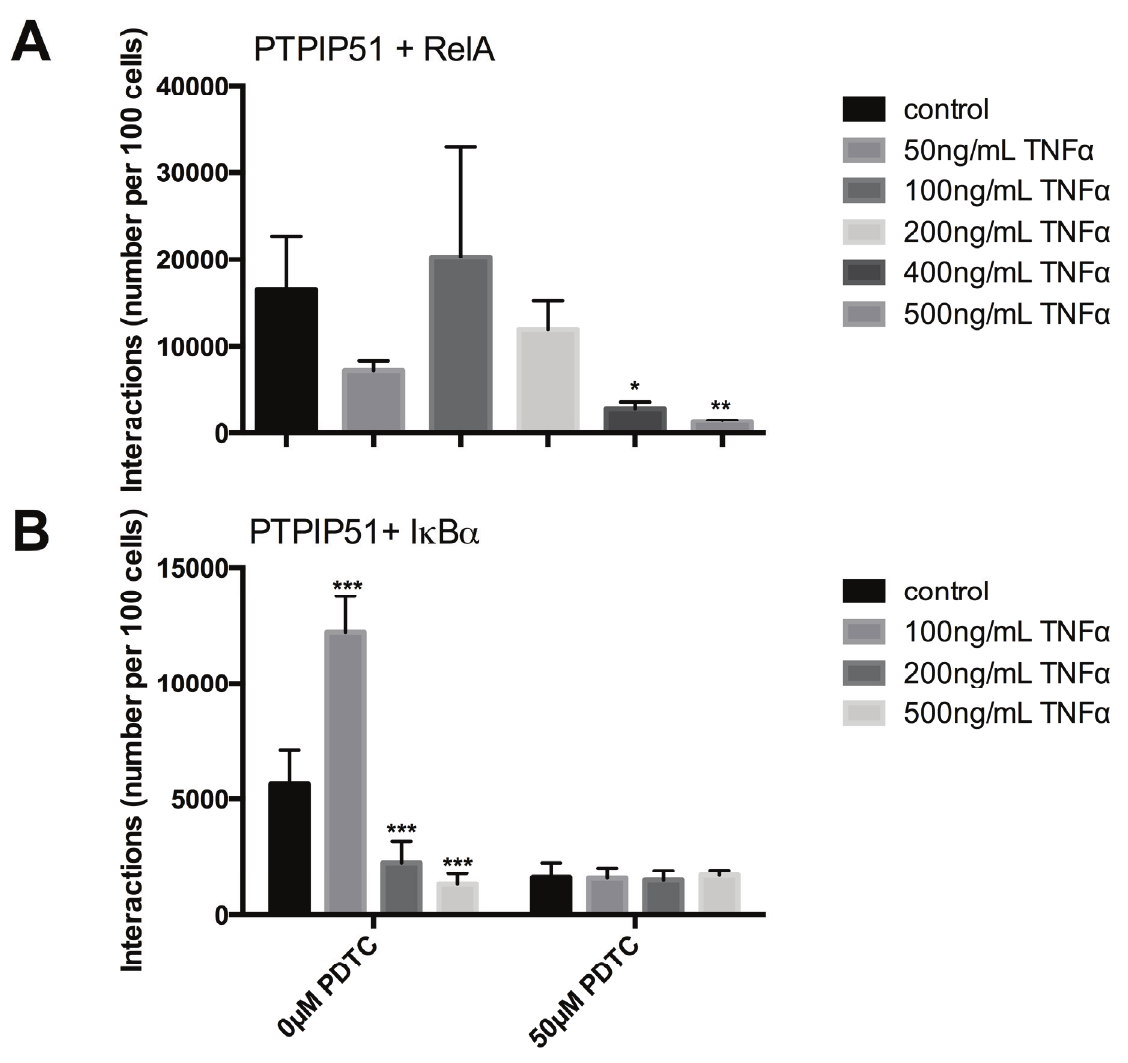
Figure 6. Quantitative analysis of PTPIP51 and RelA and PTPIP51 and IkB(cid:3) interactions evaluated by Duolink Image Tool software. ( A ) PTPIP51 and RelA interactions in human keratinocytes. Untreated controls, 50 ng/mL TNF(cid:3) treated cells, 100 ng/mL TNF(cid:3) treated cells, 200 ng/mL TNF(cid:3) treated cells, 400 ng/mL TNF(cid:3) treated cells, 500 ng/mL TNF(cid:3) treated cells. * ( p < 0.05), ** ( p < 0.01); ( B ) PTPIP51 and IkB(cid:3) interactions. Left panel: Untreated controls, 50 ng/mL TNF(cid:3) treated cells, 100 ng/mL TNF(cid:3) treated cells, 200 ng/mL TNF(cid:3) treated cells, 400 ng/mL TNF(cid:3) treated cells, 500 ng/mL TNF(cid:3) treated cells. *** ( p < 0.001). Right panel: controls, 50 ng/mL TNF(cid:3) treated cells, 100 ng/mL TNF(cid:3) treated cells, 200 ng/mL TNF(cid:3) treated cells, 400 ng/mL TNF(cid:3) treated cells, 500 ng/mL TNF(cid:3) treated cells. All cells were treated with 50 μM PDTC. The resulting data were analyzed by GraphPad Prism 6 software, significance of results tested by Dunnett’s multiple comparisons